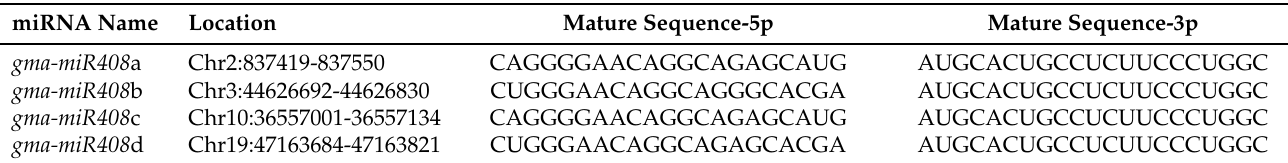
Table 1. Gma-miR408 family members described in miRbase and sRNAanno.